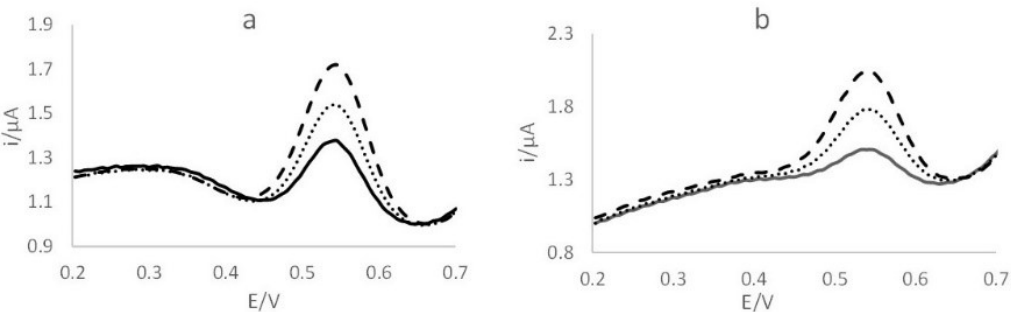
Figure 1. Voltammograms obtained using the portable kit for ( a ) Hg and ( b ) CH 3 Hg quantification: —, ERM-CE 464; ‧‧‧‧ , first addition (5 µg ‧ L −1 ); ---- , second addition (10 µg ‧ L −1 ).